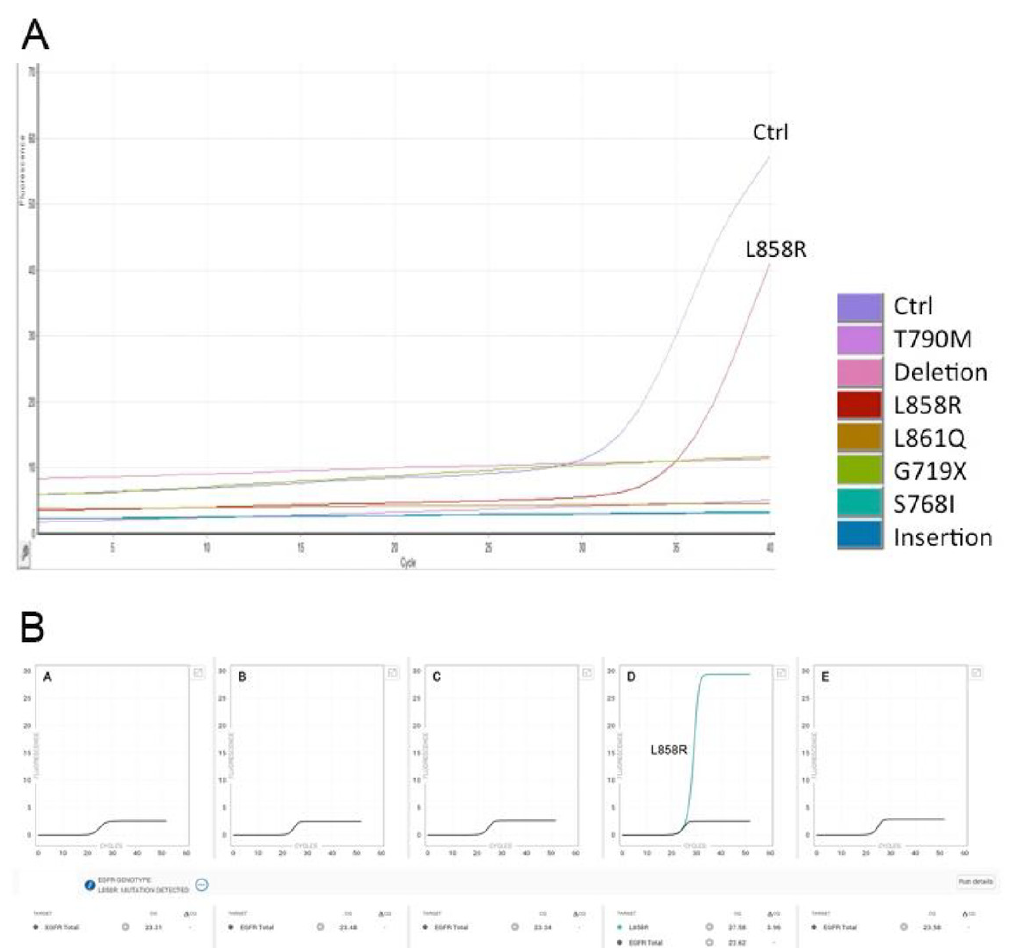
Fig. 1. The detection of EGFR L858R mutation in an 81-year-old female non-smoker. (A) Qiagen therascreen EGFR RGQ PCR Kit. (B) Idylla TM EGFR Mutation Assay